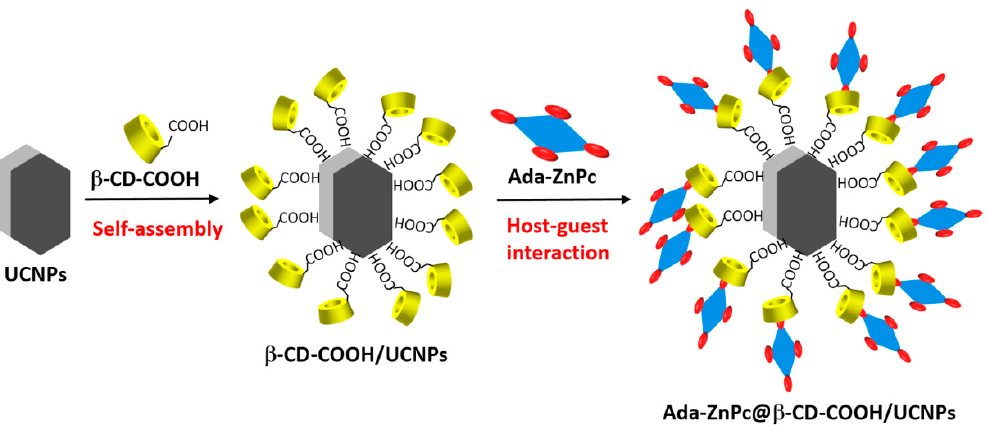
Figure 55. Schematic representation of Ada-ZnPc@ β -CD-COOH/UCNP complex. Adapted from Wang; Jin; Chen; Zhou; Zhou; Wei [192].